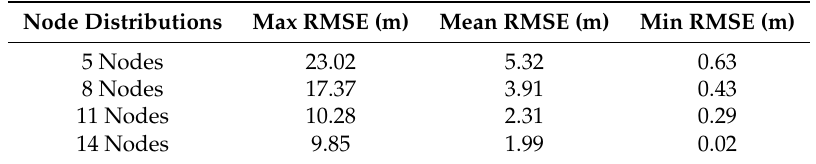
Table 3. Comparison of multiple node distributions for the scenario proposed. Results displayed refer to the maximum, mean and minimum values of the Root Mean Squared Error (RMSE) array result, obtained from Equation (13), of a single